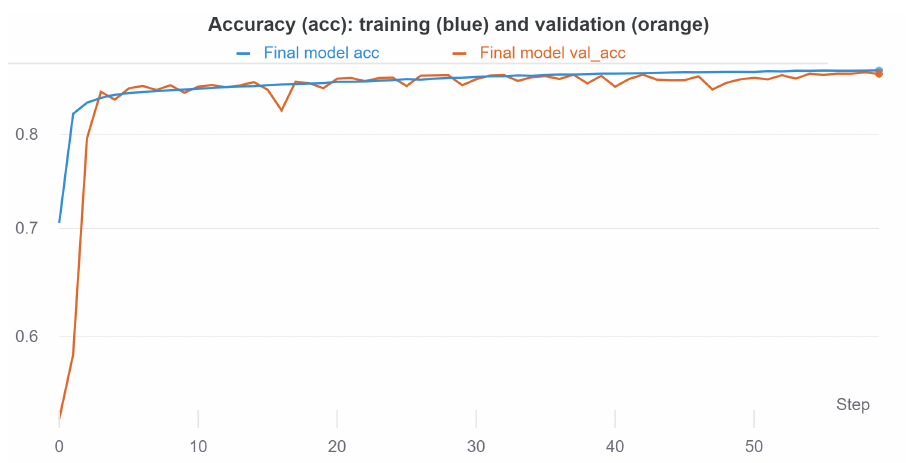
Figure 8. Plots of the percentage accuracy of the proposed model during training (blue) and validation (orange). Training accuracy reaches 88.31%, while the validation accuracy reaches